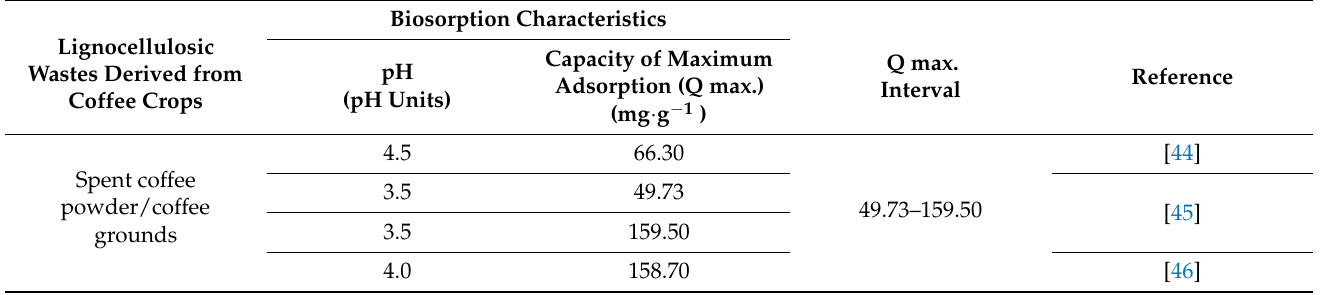
Table 4. Capacity of maximum adsorption in coffee wastes without chemical